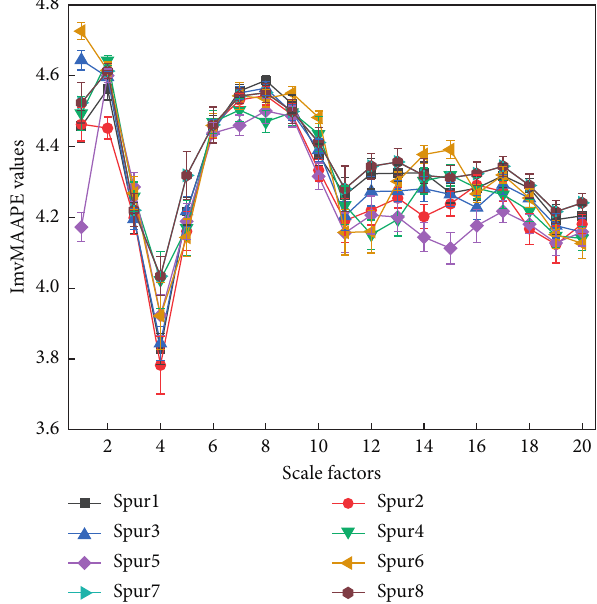
Figure 7: ImvMAAPE values’ error bar diagrams with 20 scales under 8 working